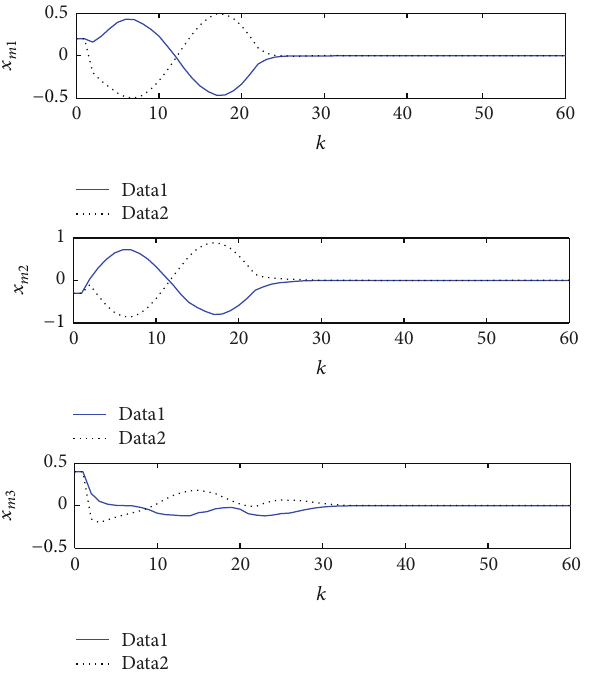
Figure 1: Trajectories and estimations of mRNAs.